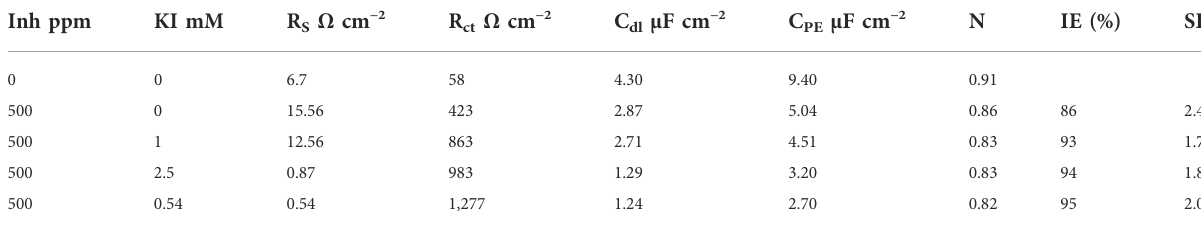
TABLE 1 Electrochemical parameters obtained from the model circuit and corrosion inhibition ef fi ciency (IE) for 1018 steel in acid media with and without 500 ppm concentration of M. sativa at different KI concentrations. Inh ppm